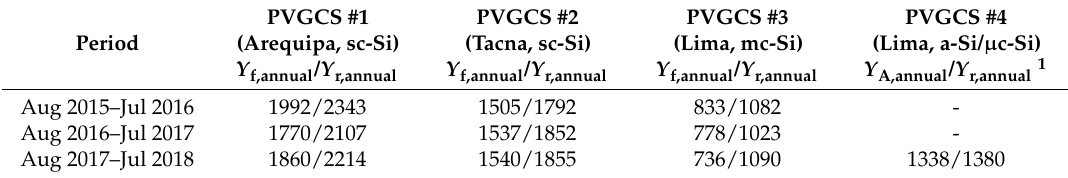
Table 3. Values of annual yields (kWh · kW − 1 ) for the four systems under study. Period